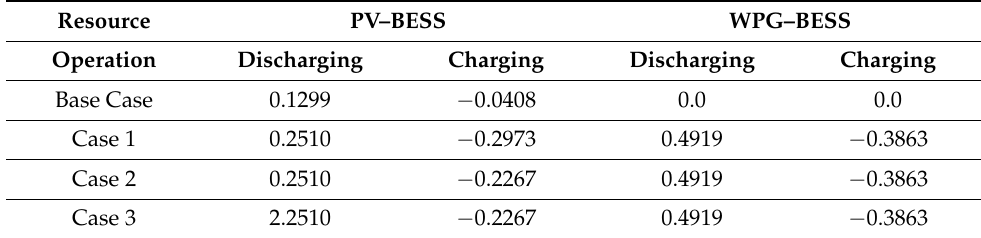
Table 16. Correlation between SMP and operations of the